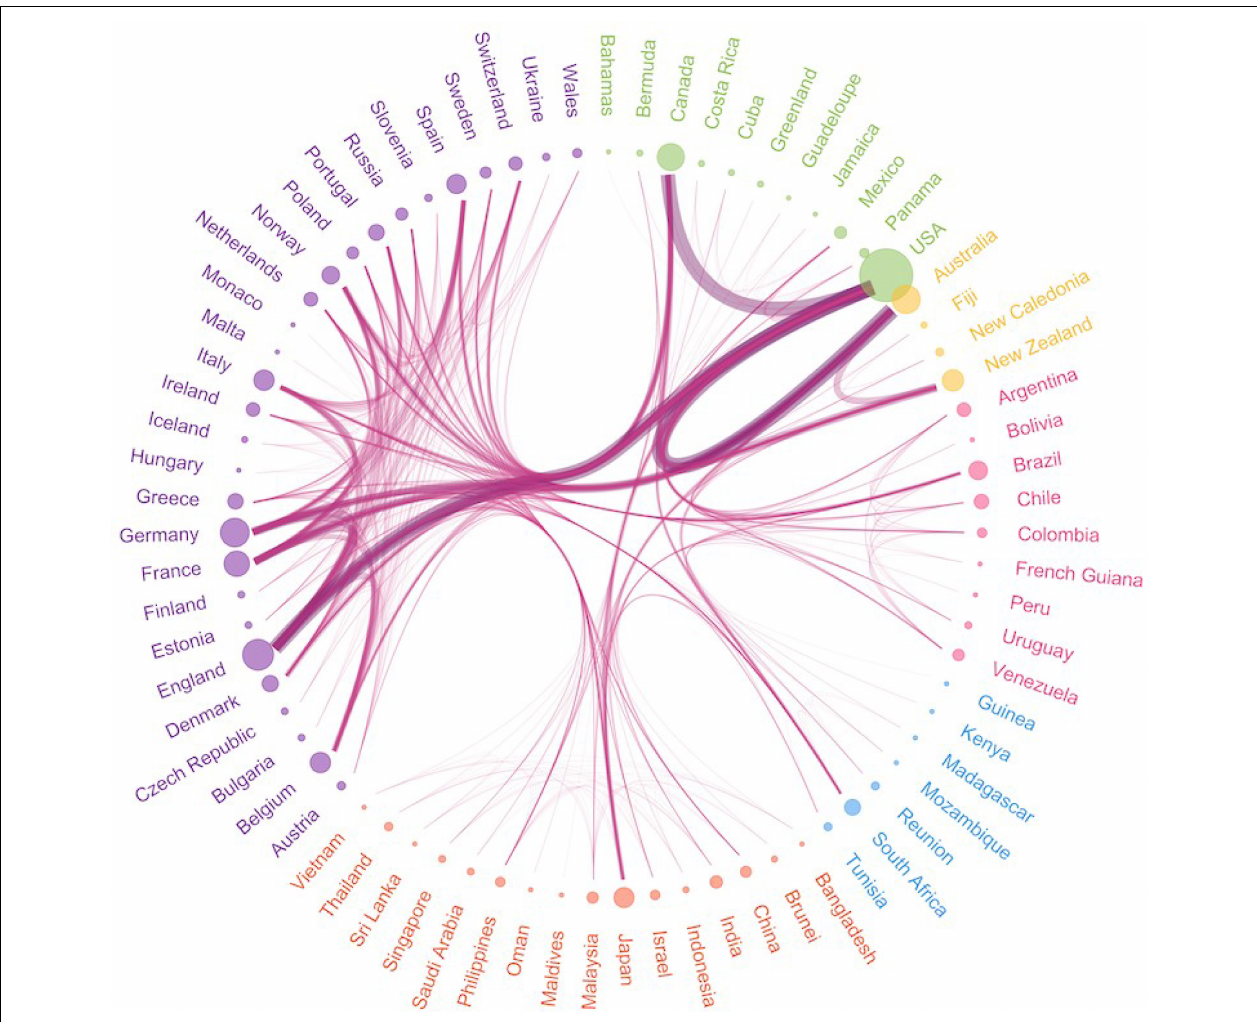
FIGURE 1 | Based on a bibliographic study in collaboration with the library of the Flanders Marine Institute, 2700 scientists from 73 countries collaborated on > 1000 papers citing OBIS. This figure shows the connections between the countries in co-authoring these papers.